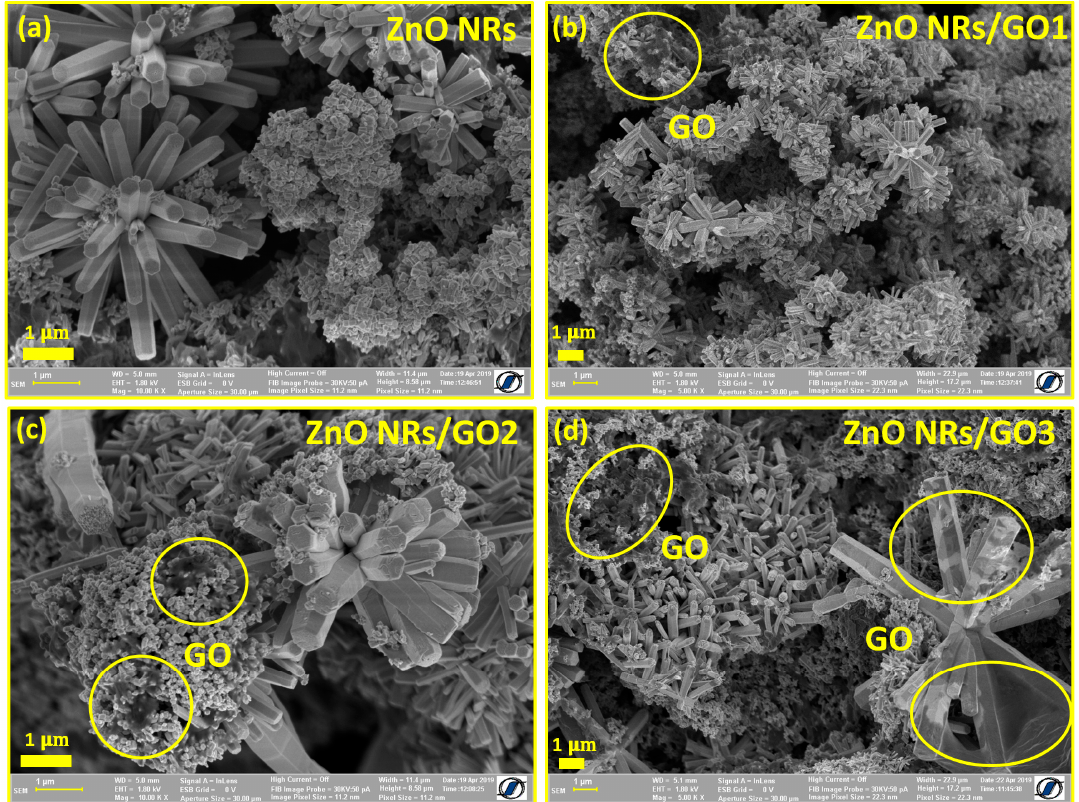
Figure 3. Field-emission scanning electron microscope (FESEM) images of ( a ) ZnO NRs, ( b ) ZnO NRs/GO1, ( c ) ZnO NRs/GO2, and ( d ) ZnO NRs/GO3 nanocomposites.